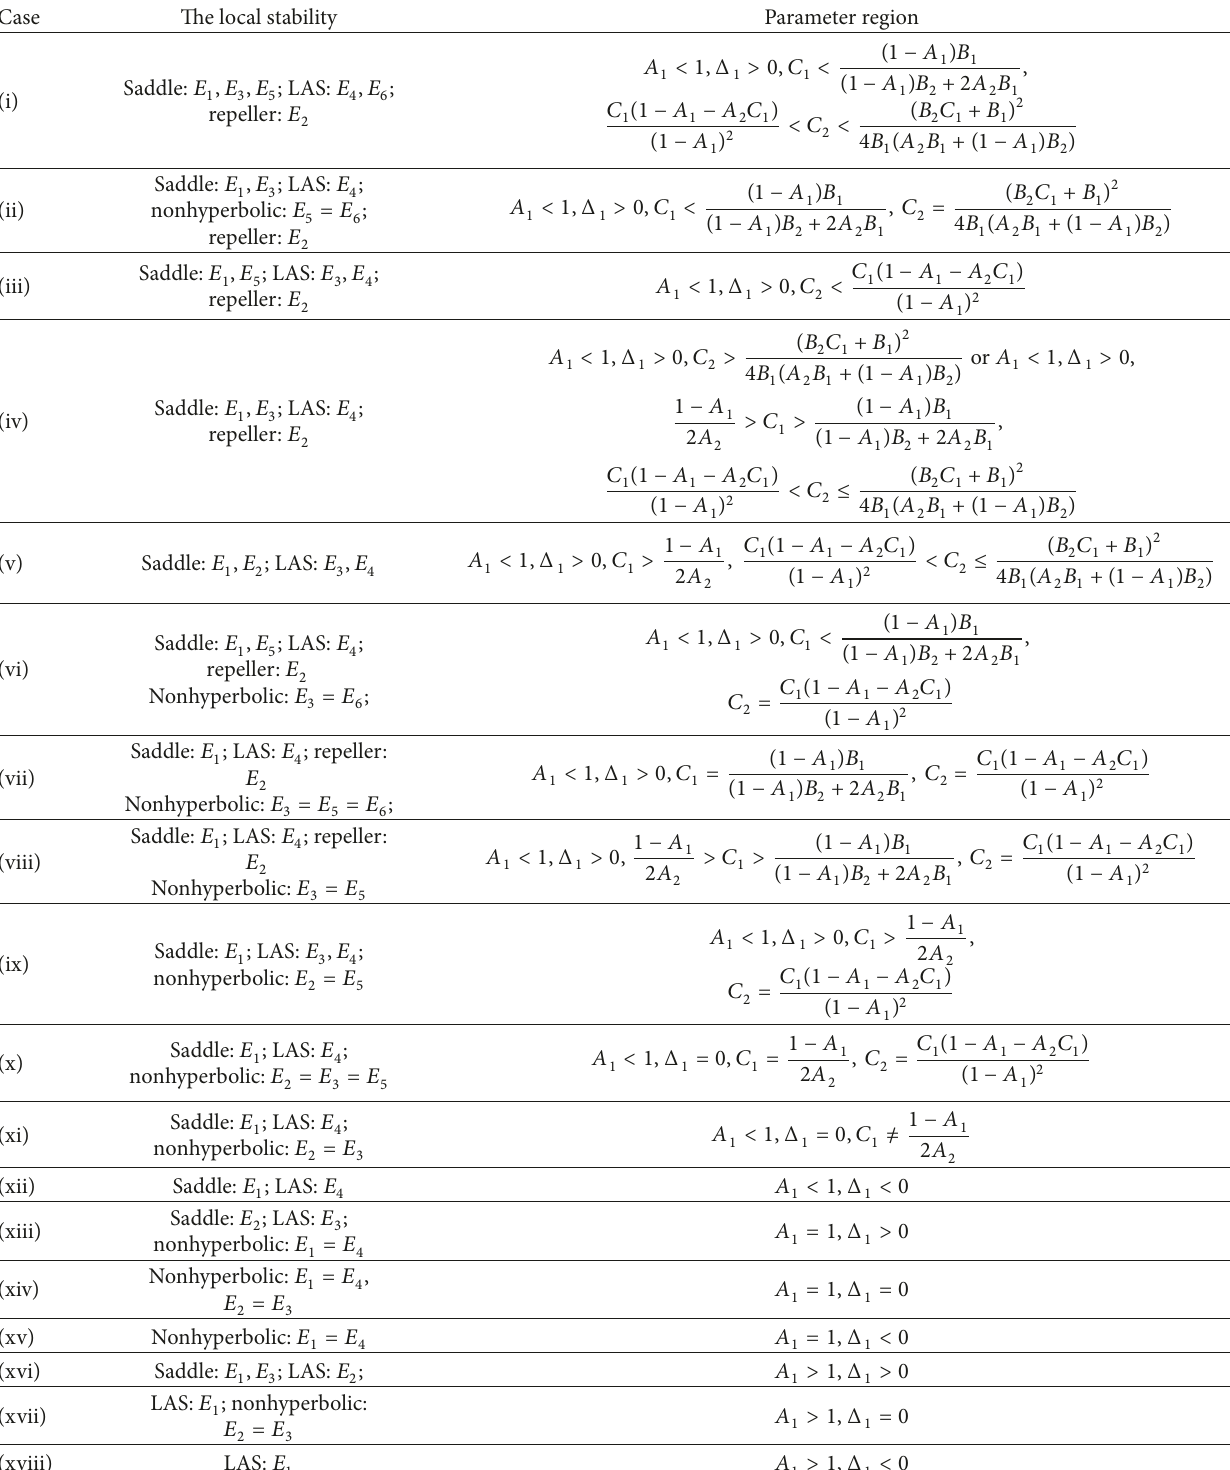
Table 2: The local stability of the equilibrium